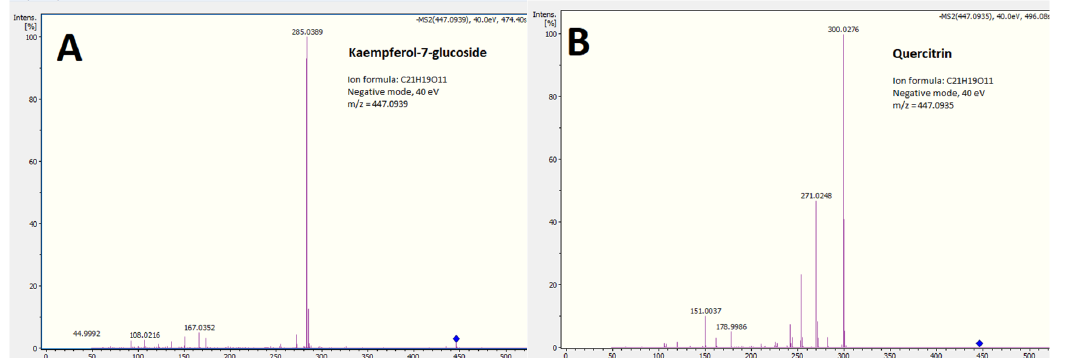
Figure 2. UPLC-MS/MS fragmentation spectra of putative kaempferol-7-glucoside ( A ) and quercitrin ( B ) at 40 eV in negative ionization mode, m / z = 447.093 present in extracts of all three plant species. The blue diamond symbol represents the parent ion mass before MS 2 fractioning.